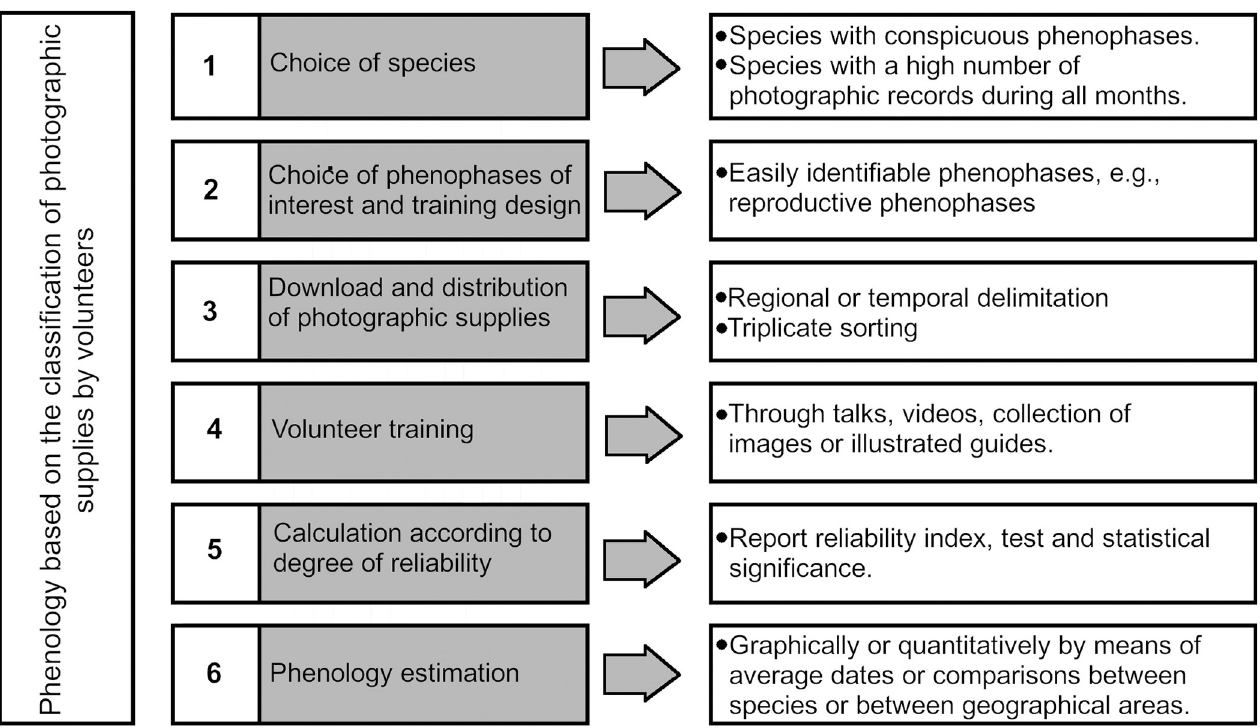
Fig 1. Flowchart followed to generate the phenology of species from records of